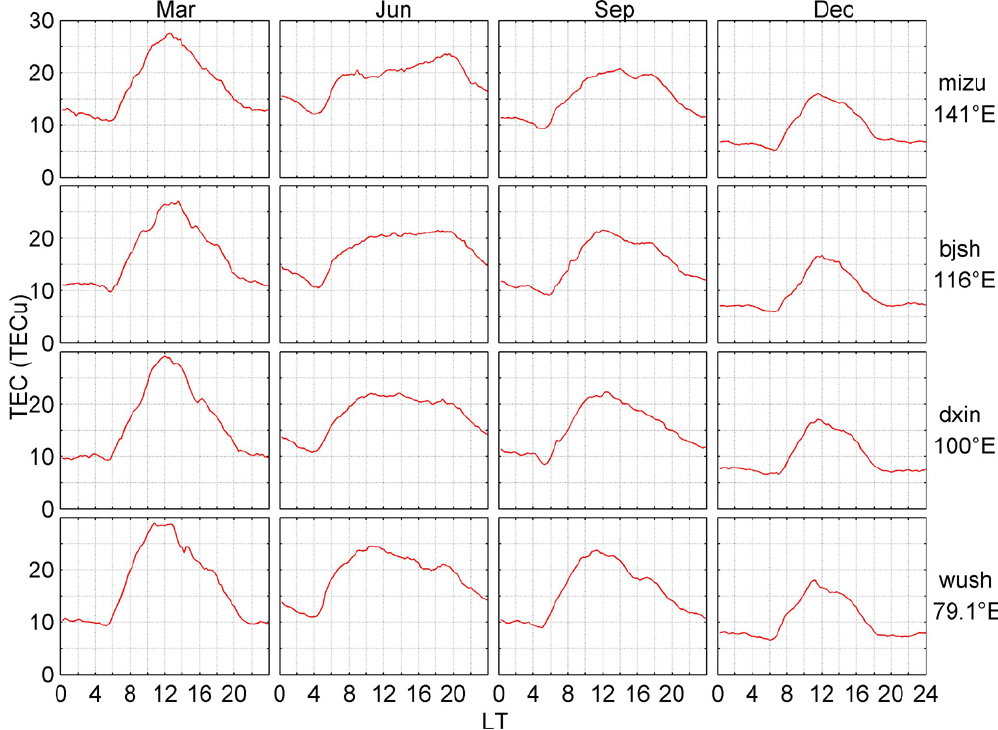
Fig. 5. Diurnal variations of TEC (median) in four months (March, June, September and December) in 2004 at 4 GPS sites along 40 ◦ N.